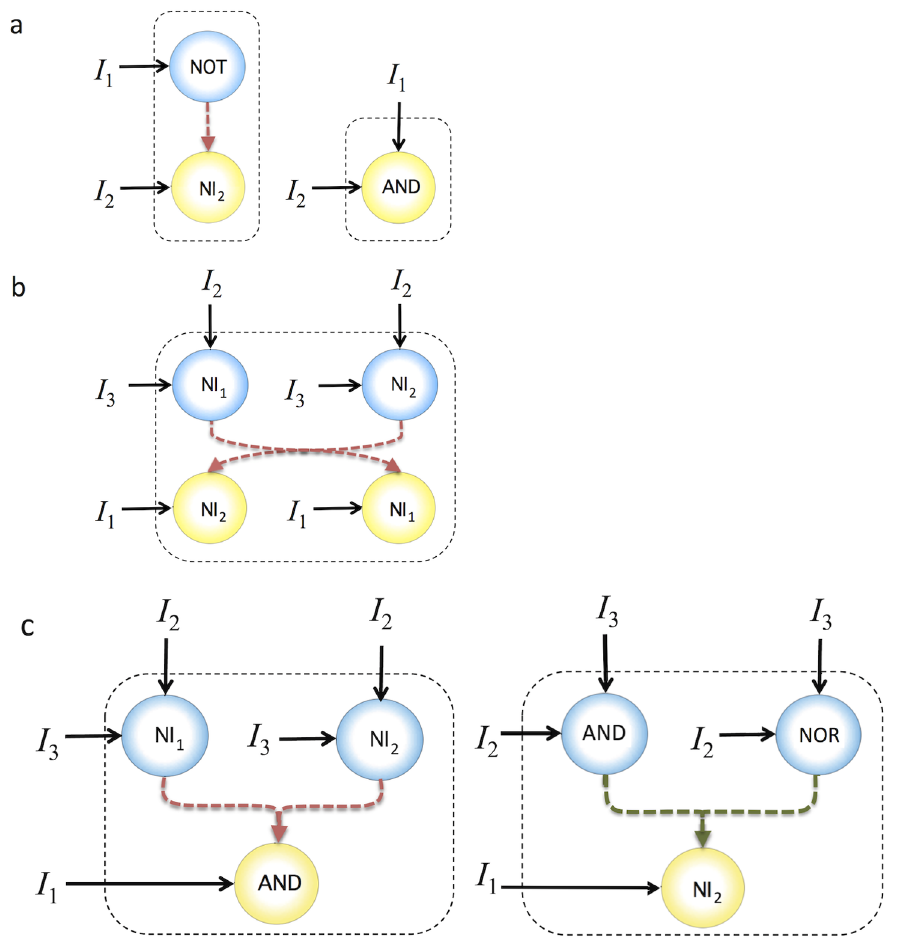
Figure 5. Examples DMC designs obtained by using an evolutionary algorithm to find solutions to given computational functions, as defined by Boolean tables of the examples shown in figure 4. The coloured balls represent the basic set of engineered cells indicating their internal Boolean functions. The dashed boxes indicate subsets of cells linked through the same communication signal (wire) represented by coloured dashed arrows. In (a) the binary comparator circuit is shown, after all simplifications have been performed. Figure (b) shows a DMC circuit implementing a binary three-bits adder using distributed logic. Finally, in (c) we display the minimal three-bit parity circuit is shown. Although the standard circuit is quite complex, a cell consortia involving six different cell types is enough to implement this complex function. Of note, these examples involve two different wires at the most in the most complex circuit and hence a real wet lab implementation is feasible.